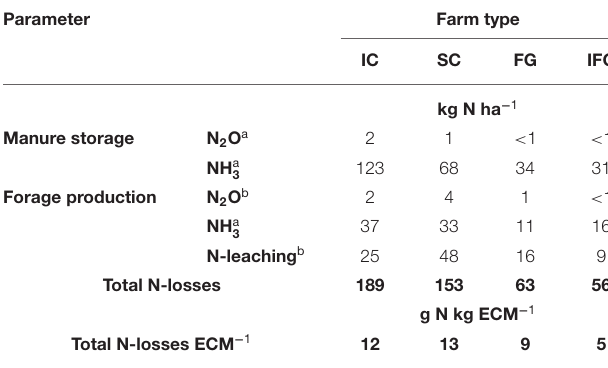
TABLE 5 | Measured and predicted losses expressed in kg N ha − 1 of reactive nitrogen from the different systems (IC, intensive-confinement; SC, semi-confinement; FG, full-grazing; IFG, integrated full-grazing) as well as the N-footprint per kg energy corrected milk (g N kg ECM − 1 ). Parameter Farm type IC SC FG IFG kg N ha − 1 Manure storage N 2 O a 2 1 < 1 < 1 NH a 3 123 68 34 31 Forage production N 2 O b 2 4 1 < 1 NH a 3